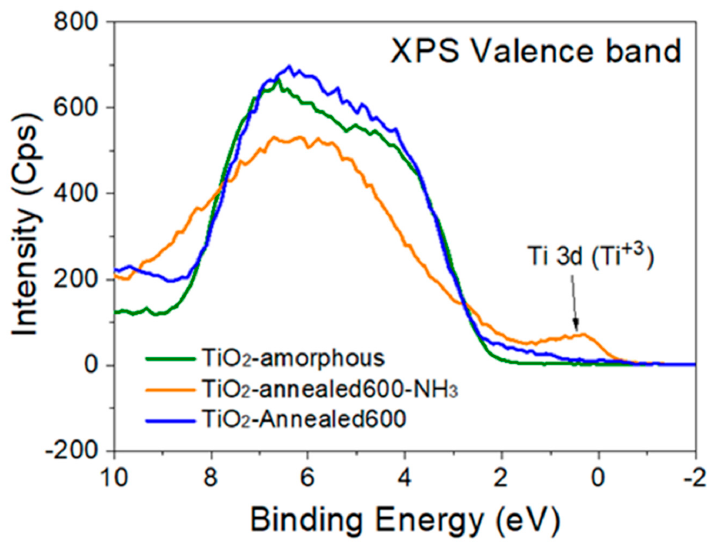
Figure 3. X-ray photoelectron spectroscope valence band spectra of different titania films. Upon curve fitting of the N 1s XPS core level spectrum, appears a β‐ N peak repre ‐